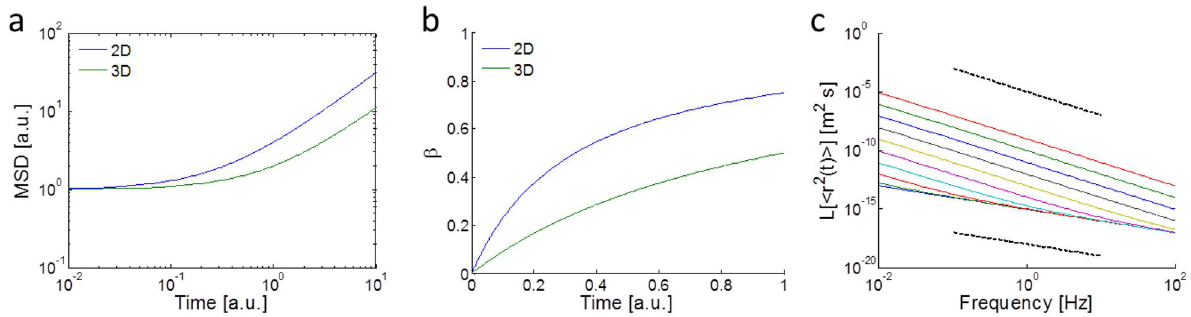
Figure 7. Simulated MSDs and b ’s for 2D and 3D systems using the effective temperature model to account for active stress fluctuations. a,b) Simulated (a) MSDs and (b) corresponding b ’s for cells in 2D (blue) and 3D (green). Cells in 2D have a larger stress fluctuation term A (3 times larger in this case). c) The Laplace transform of the MSDs based on the effective temperature model for different A ’s (from 0.001 to 10 6 [1/ s]) and fixed s 0 =0.001 Hz. The simulations in (c) assume an elastic material (G is constant and equal to 20 Pa) with 70 nm-radius tracer particles at T=300 K and power-law trends are attributed to the effective temperature. The bottom and top dotted lines have slopes of 1 and 2, indicating thermal and super-thermal (with motor activity) spectral trends, respectively. doi:10.1371/journal.pcbi.1003959.g007 PLOS Computational Biology |